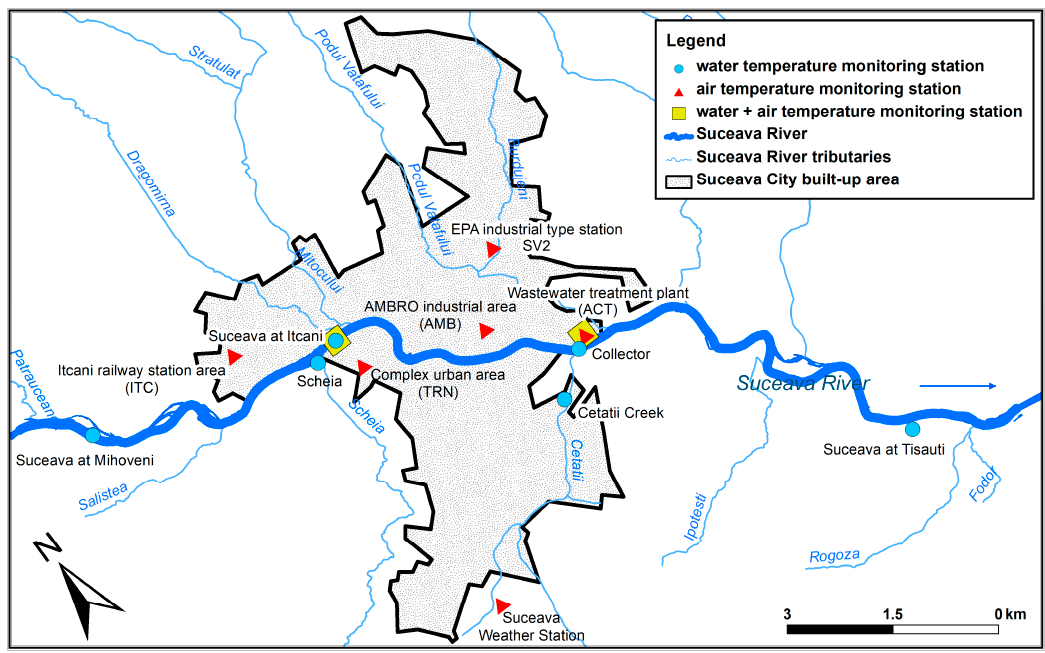
Figure 1. Map of the study area (centred on Suceava city) and location of the monitoring stations.